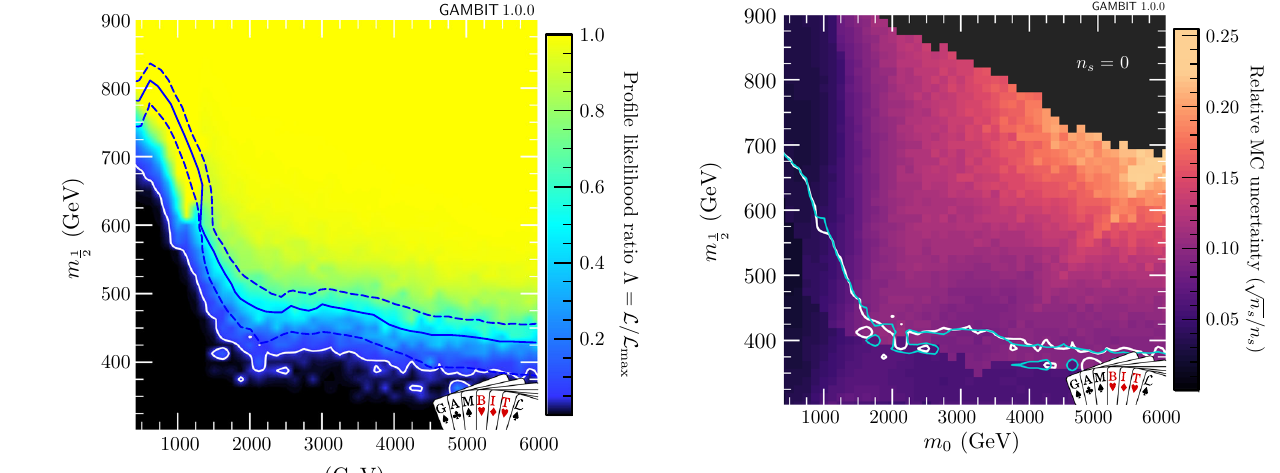
√ Fig. 4 The relative MC uncertainty n s / n s for ColliderBit simula- tions of the ATLAS zero lepton SUSY search across the plane of m 0 and m 1 / 2 , using 20,000 MC events per parameter point. Here n s is the number of accepted MC signal events. As in Fig. 3, the remaining CMSSM parameters are given by tan β = 30, A 0 = − 2 m 0 and μ > 0. Thesolidlinesshowthe GAMBIT 95%CLexclusioncontoursobtained using 20,000 (white) and 100,000 (cyan) MC events by ColliderBit for the given parameter point. As in Fig. 3, the white line depicts the 95% CL exclusion contour